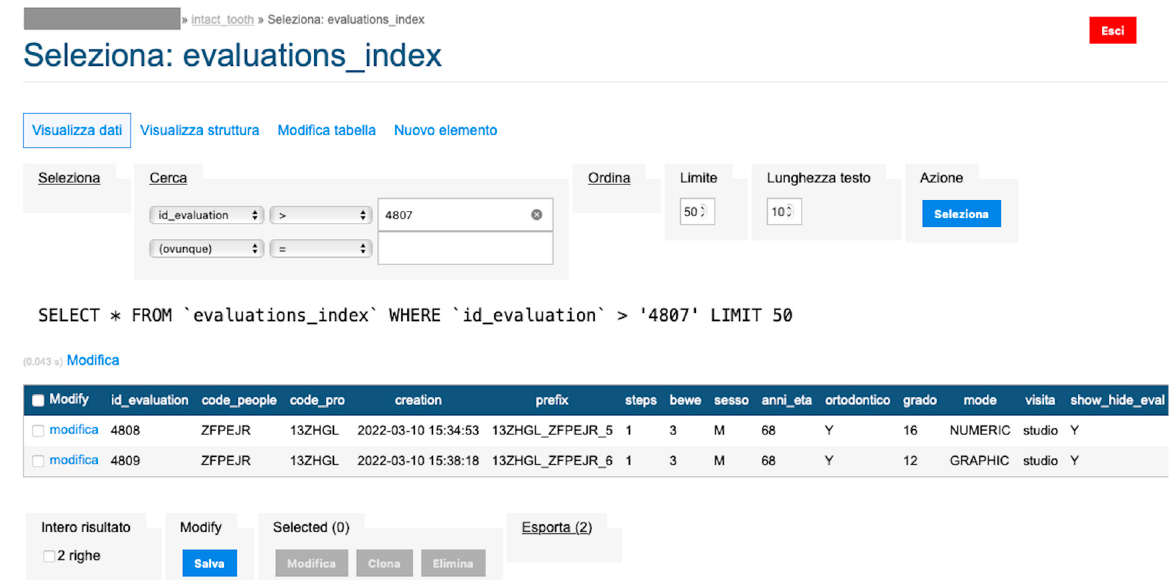
Figure 12. Shows the first part of evaluation index process.